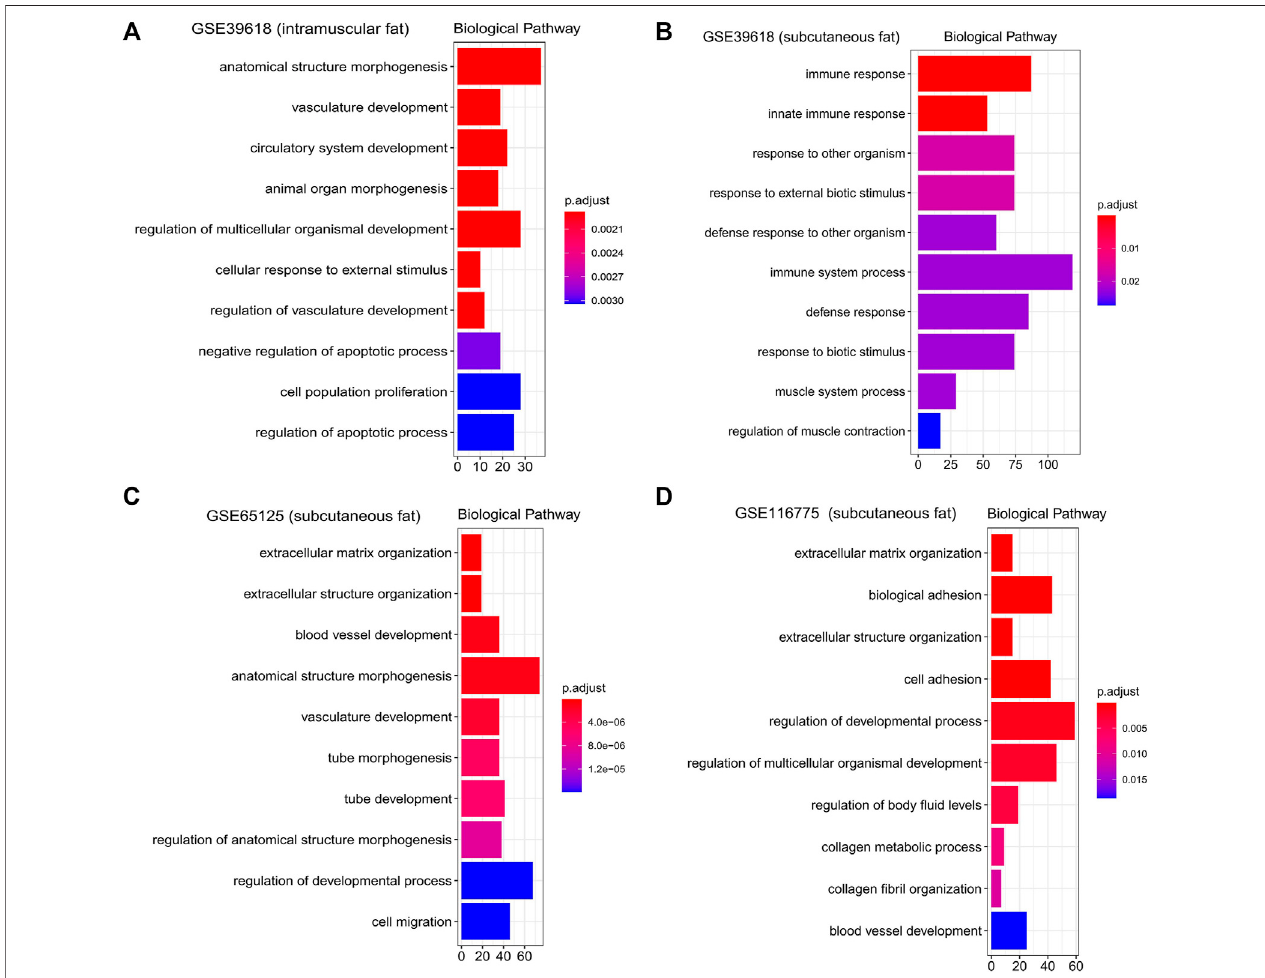
FIGURE 6 | Gene ontology enrichment analysis of interested modules. GO analysis (Biological pathway) of genes signi fi cantly related to intramuscular fat in the brownmodule (A) ,inter-ribssubcutaneousfatintheturquoisemodule (B) ,abdominalsubcutaneousfatintheyellowmodule (C) anddorsalsubcutaneousfatintheblue module (D)